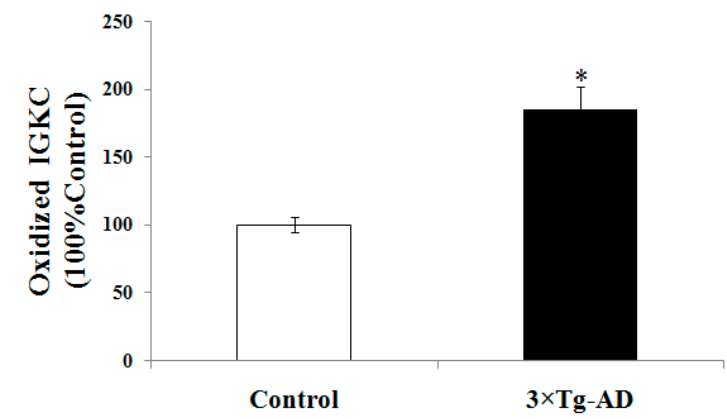
Figure 7. Immunoprecipitation followed by Western blot analysis was performed to confirm the carbonylation of IGKC protein in serum. ( A ) The expression level of the protein was detected with anti-IGKC antibody (WB). The efficiency of immunoprecipitation was checked with anti-IGKC antibody (IP + WB). The protein was immunoprecipitated with its antibody and Western blot analysis with anti-DNP antibody (IP + DNP-derivate + WB); ( B ) histograms show the alteration of protein-carbonylated levels, in which the measured value is normalized with the mean of the control subjects ( n = 3). * p < 0.05 vs. the control.